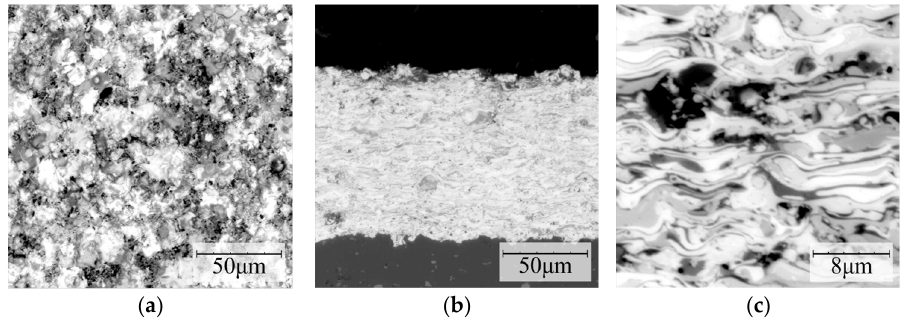
Figure 6. Surface morphology ( a ) and microstructure ( b , c ) of developed coating with the addition of 10 wt. % of YSZ plasma-sprayed using optimal parameters (I = 450 A, H 2 flow 5 NLPM, powder feed rate 20 g/min).